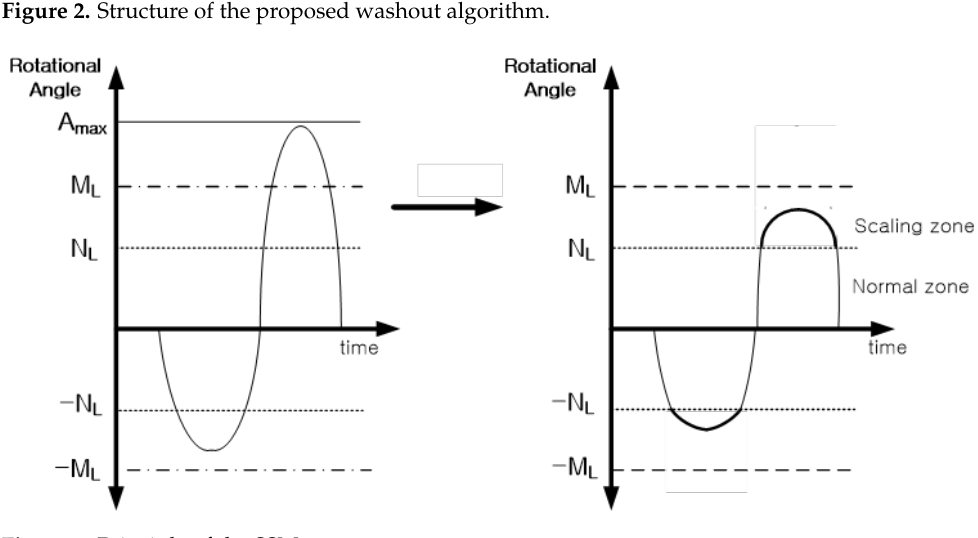
Figure 3. Principle of the SSM.